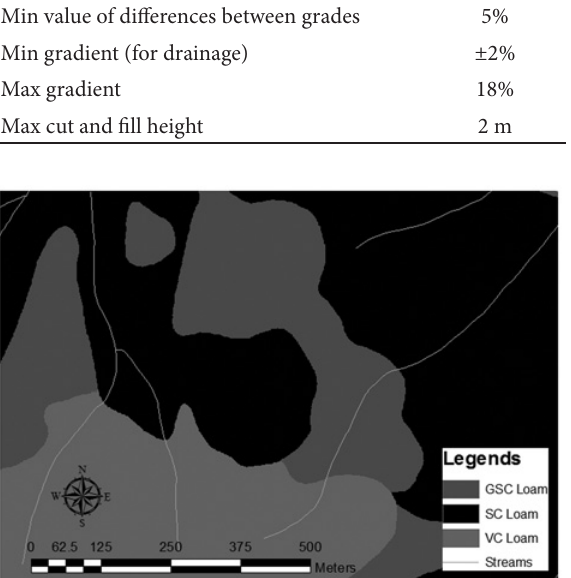
Fig. 2. The soil and stream layers in study area